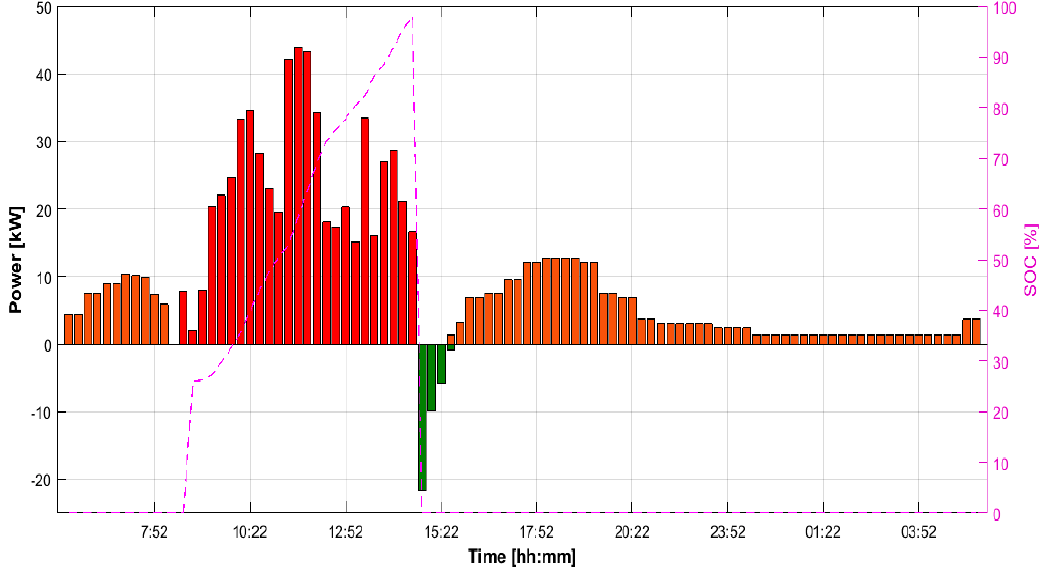
Figure 19. Final energy absorption of the car park distribution.